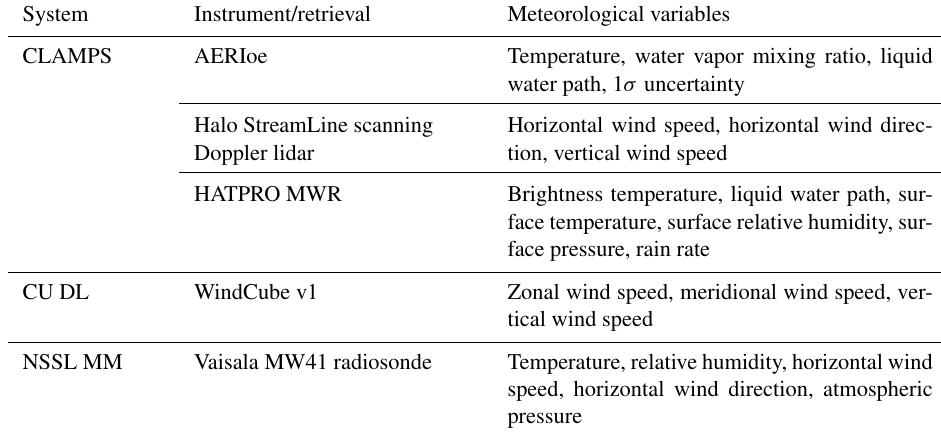
Table 2. A list of the systems described in the paper with details about the instruments/retrievals provided by each system. Additionally, the major meteorological variables produced by each instrument/system are included.